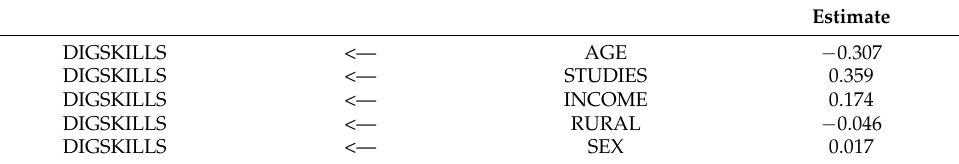
Table A20. Standardized Regression Weights: (Group number 1-Default model).